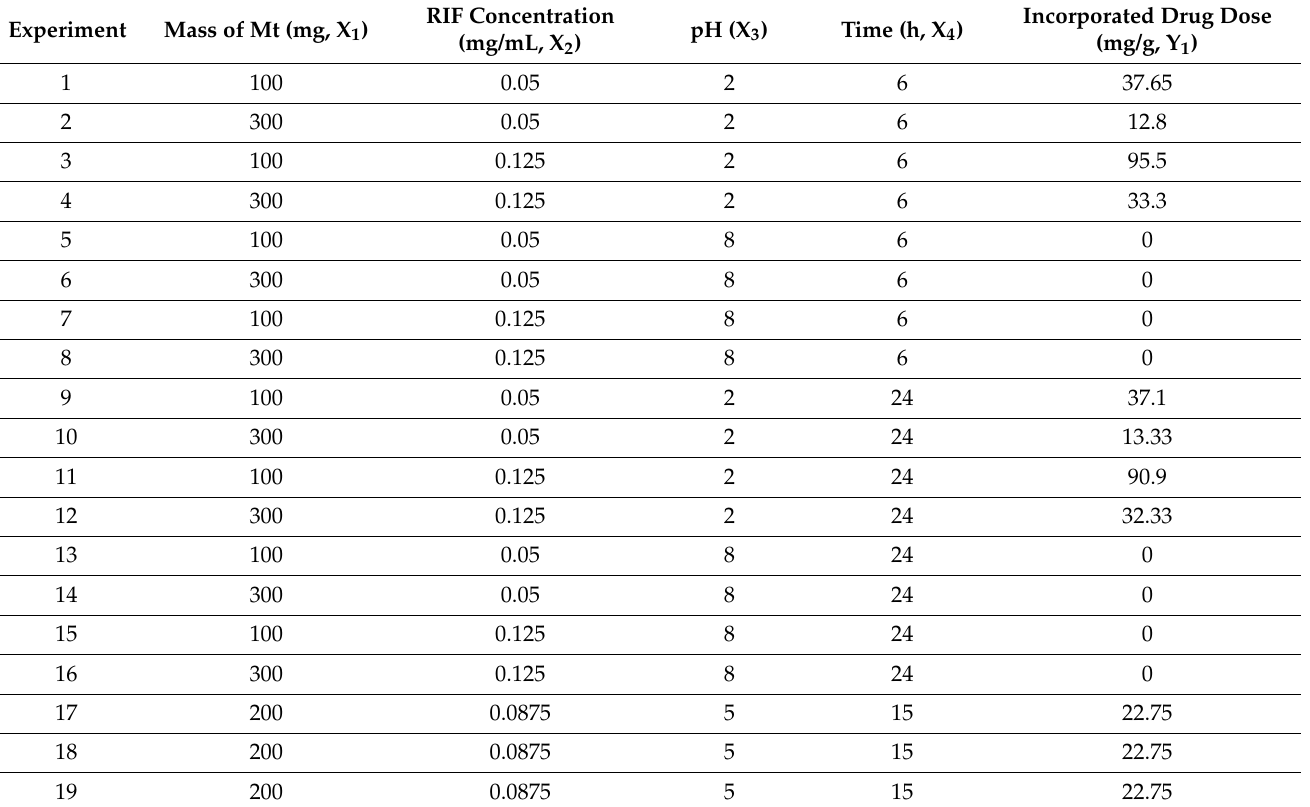
Table 3. Response values obtained for evaluating the process of incorporation of RIF in Mt using experimental design 2 4 of the CCD type.